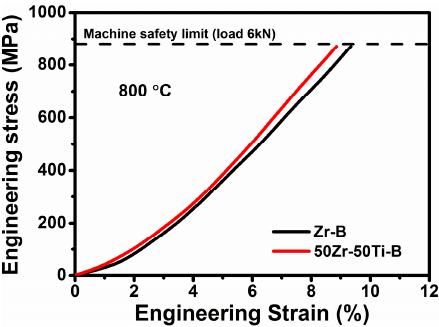
Figure 11. High temperature compressive strength of RSPSed samples.